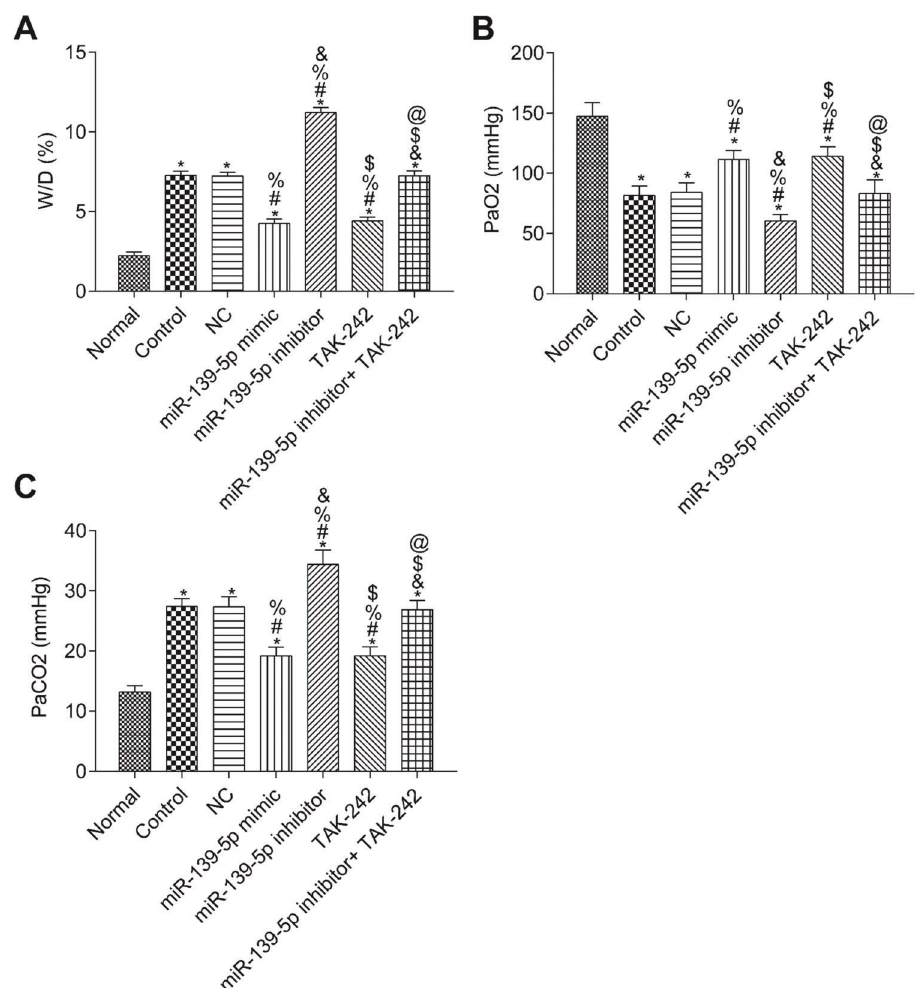
Figure 3 - The W/D, PaO 2 and PaCO 2 of mice in each group. W/D of mouse lung tissue (A); PaO 2 in mice (B); PaCO 2 in mice (C). Significant comparisons with each group, where p o 0.05, are indicated by: ‘‘ * ’’ for the Normal group, ‘‘ # ’’ for the Control group, ‘‘ % ’’ for NC group, ‘‘ & ’’ for the miR-139-5p mimic group, ‘‘ $ ’’ for the miR-139-5p inhibitor group, and ‘‘ @ ’’ for the TAK-242 g roup PaO partial pressure; W/D, lung tissue wet-to-dry mass ratio; PaCO 2 , carbon dioxide partial